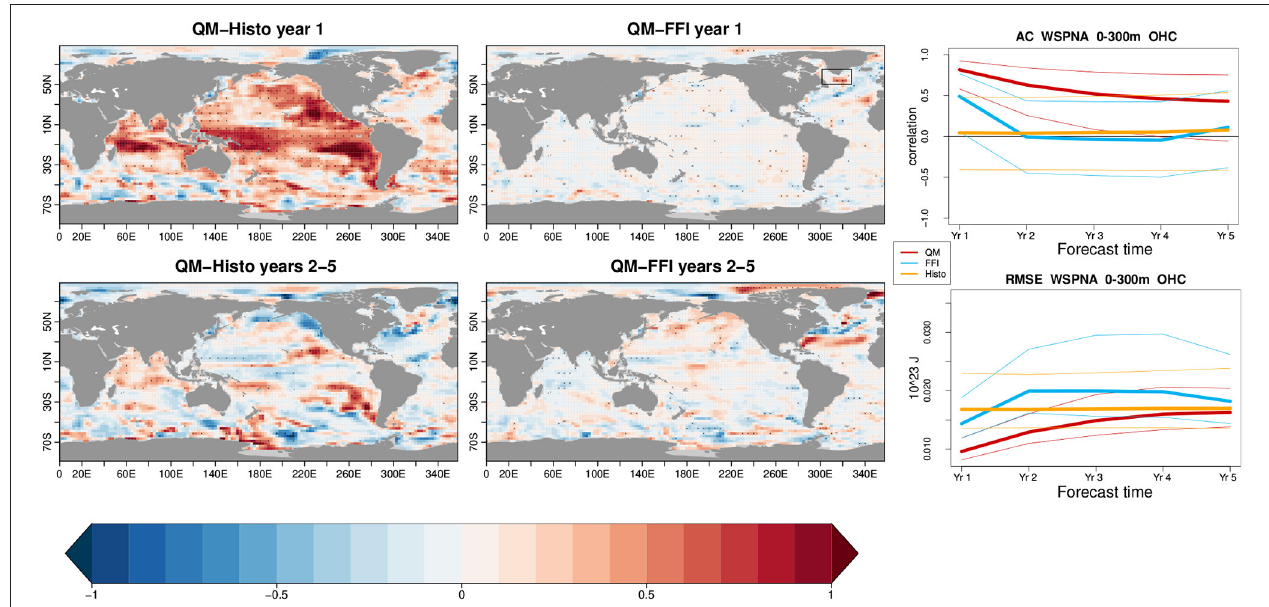
FIGURE 6 | Skill difference in the upper 300 m ocean heat content, computed against EN4 observational dataset. The first column shows the anomaly correlation (AC) difference between quantile matching (QM) and Histo for the first forecast year (top) and the 2–5 forecast years (bottom) . The second column shows the difference between QM and full-field initialization (FFI). The third column is a zoom on the regional mean of the western subpolar North Atlantic sector (WSPNA; 50–65 ◦ N, 60–30 ◦ W) as indicated by the black box. The AC and root mean square error (RMSE) are calculated with yearly mean data along the forecast time and are shown, respectively, in the top and bottom panel. In red is shown the QM experiment, in blue the FFI, and in yellow the Histo. The thin lines represent the 95% confidence interval obtained with a t-distribution for the correlation and a χ 2 distribution for the